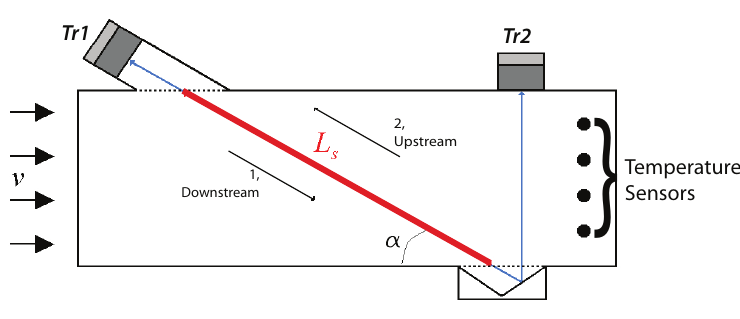
Figure 2. Schematic